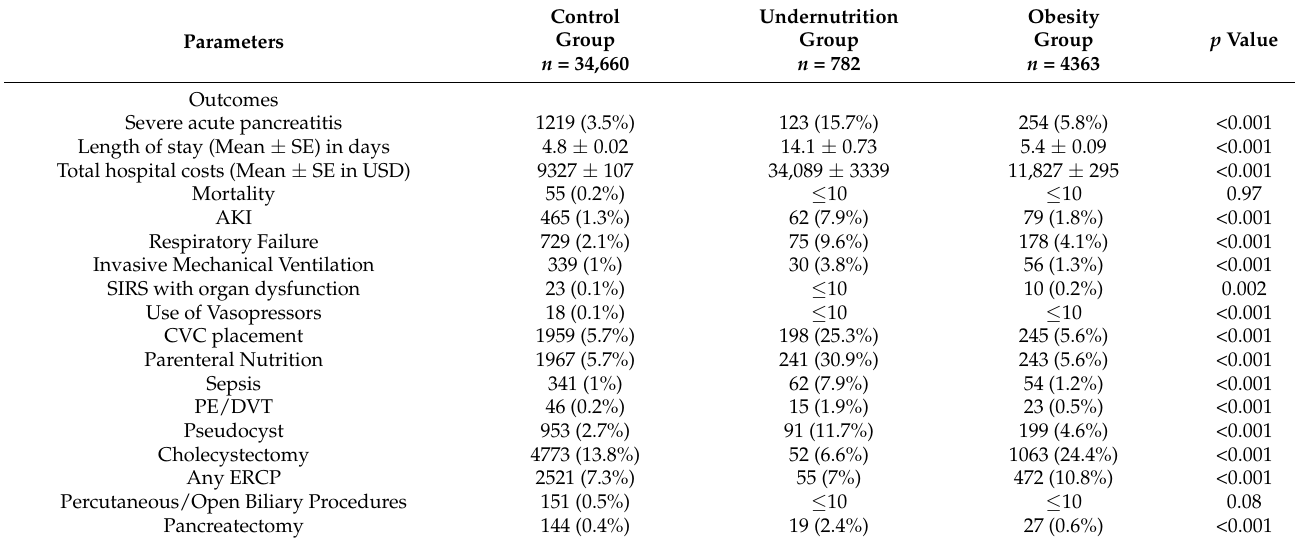
Table 2. Comparison of surgical interventions and clinical outcome measures in acute pancreatitis. Patients are stratified based on nutritional status: Kids’ Inpatient Database 2003, 2006, 2009, 2012 and 2016.